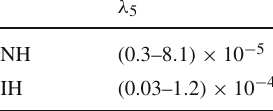
Table 3 The range of λ 5 allowed by phenomenological requirements of satisfying direct detection bounds and generating the required lepton